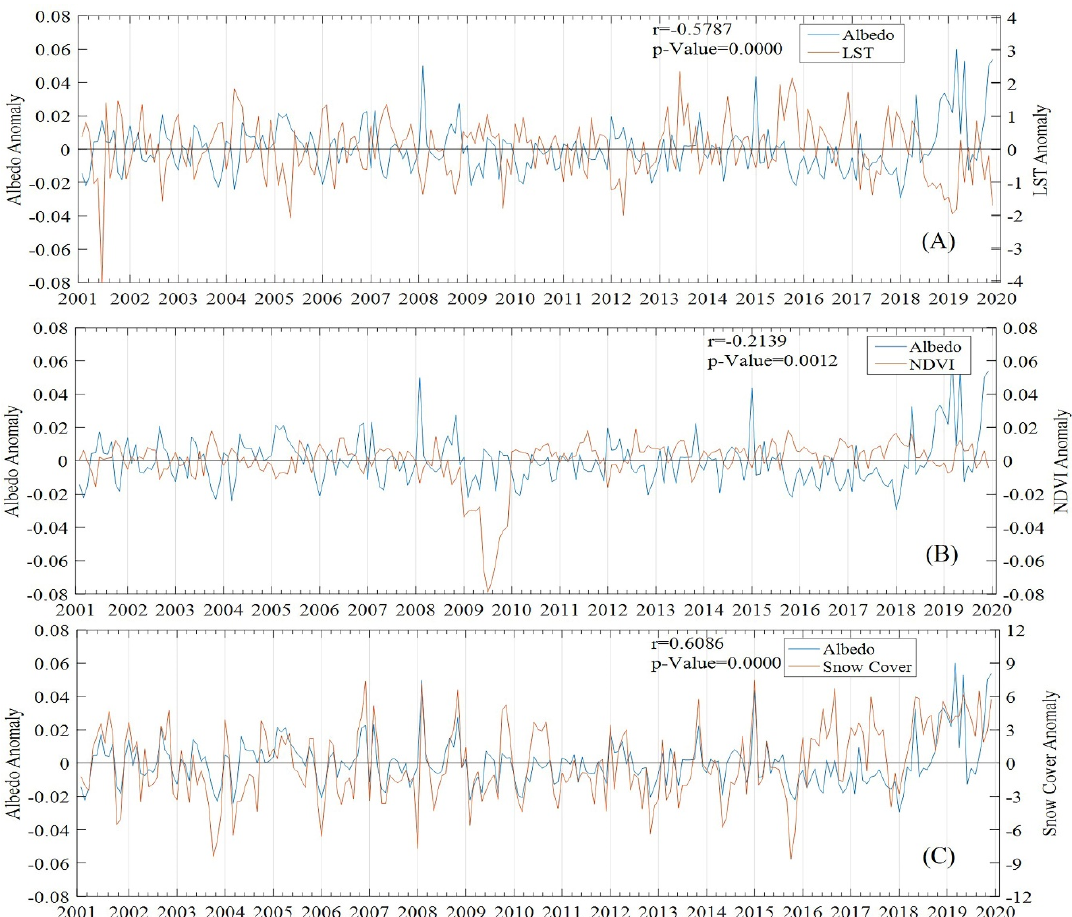
Figure 5. The evolution of the monthly averaged albedo ( A ), land surface temperature (LST), normalized difference vegetation index (NDVI) ( B ), and the fraction of snow cover anomaly ( C ).